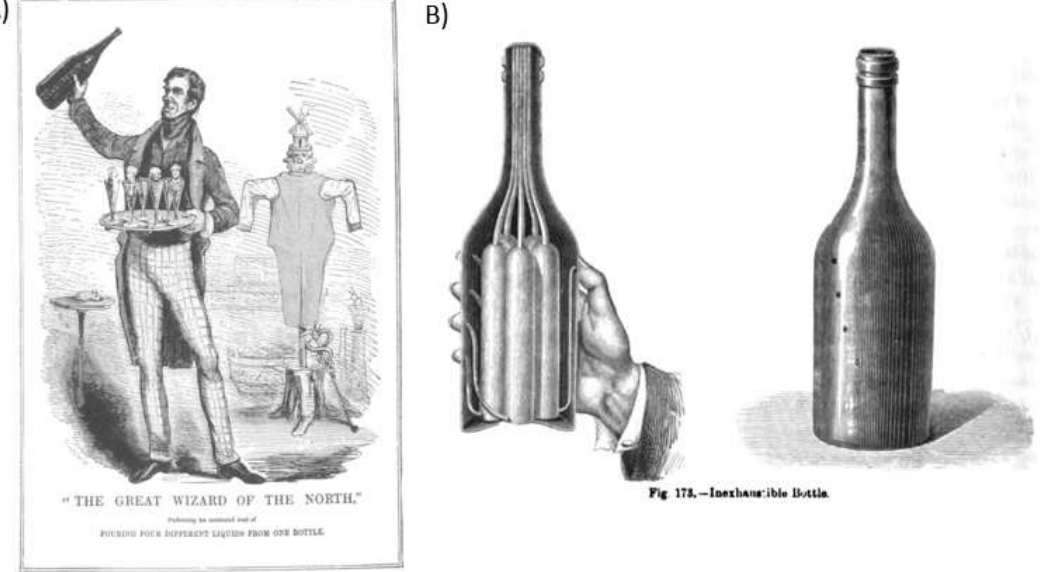
Figure 1. ( A ) John Henry Anderson, the “Wizard of the North” demonstrates the Inexhaustible Bottle trick on the playbill for an 1843 performance at the Victoria Rooms, Hull (UK) from April 1838. [Harry Houdini, re-producing work from the mid 1800's—[39]; ( B ) Privat-Deschanel's “Elementary treatise on natural philosophy” explains the use of the Inexhaustible Bottle as a way to cleverly demonstrate the basic principles of hydrostatics (c. 1884) [40].